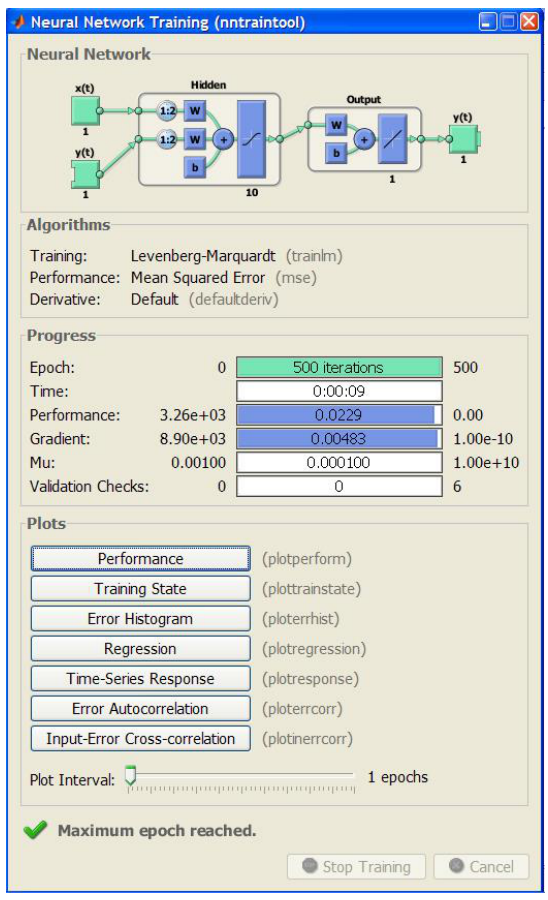
Figure 8. Matlab neuronal network configuration expressing vehicle speed.